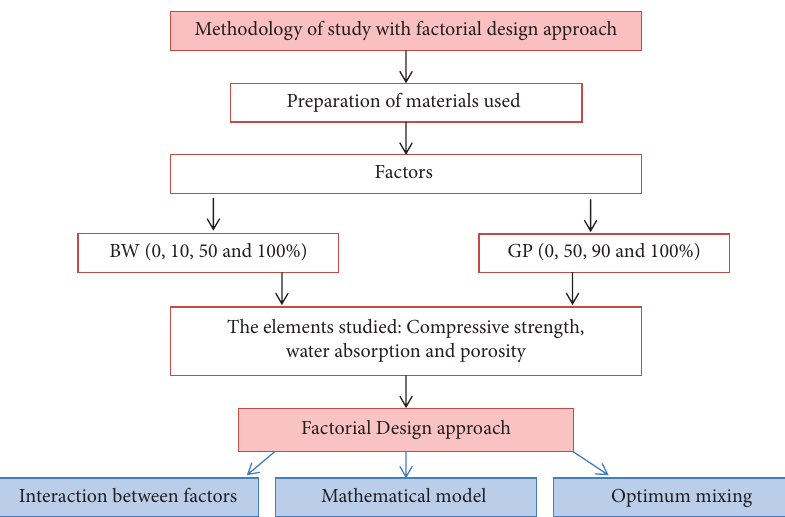
Figure 1: Flowchart related to the steps followed by the F.D.A.